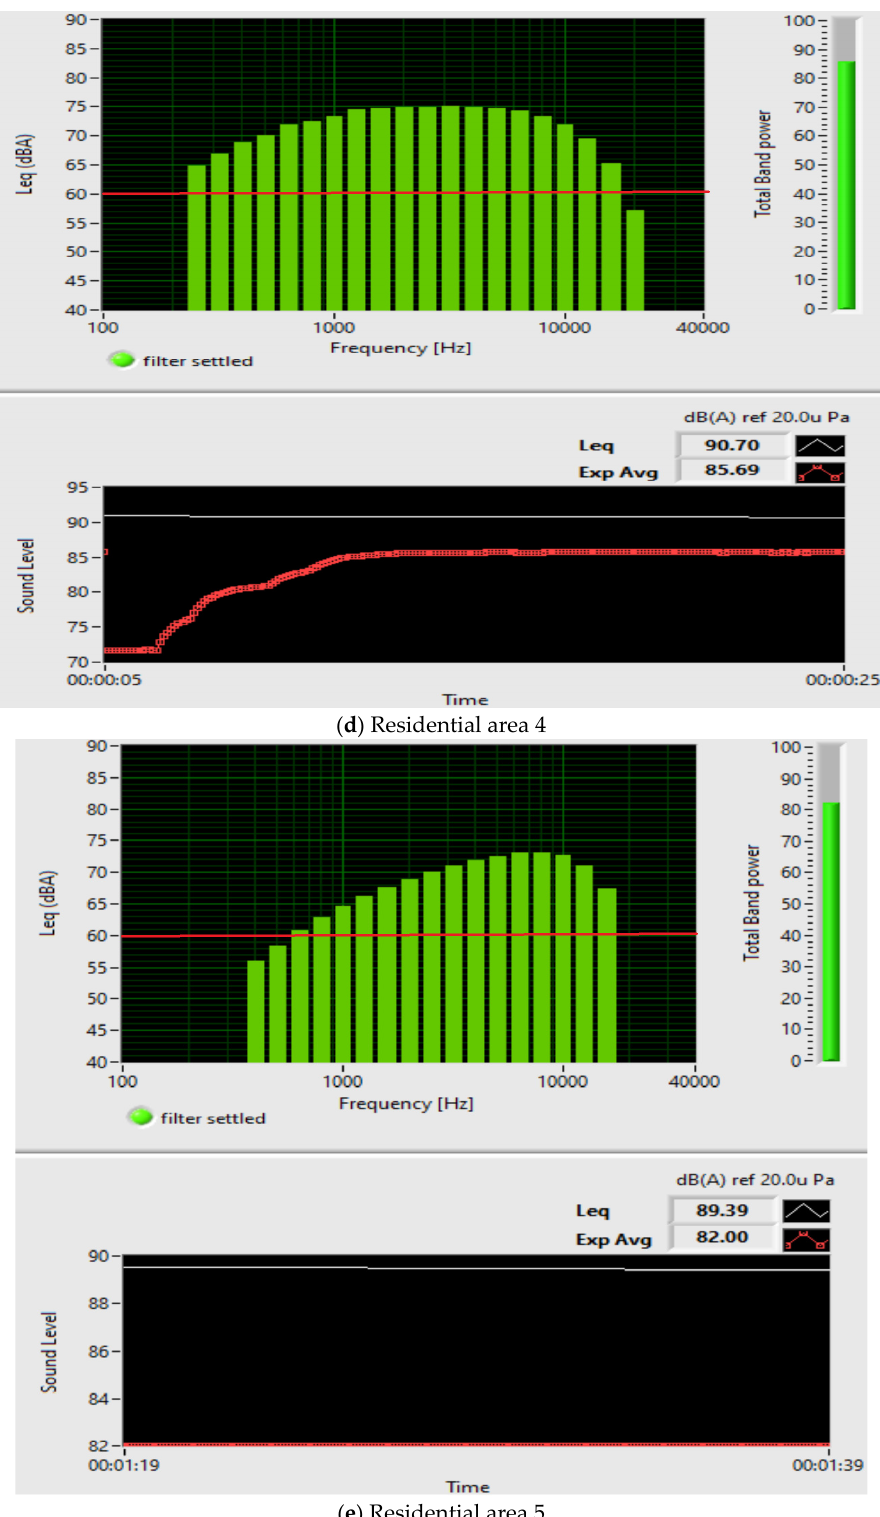
Figure 24. Noise pollution levels determined for five residential areas in Bucharest, Romania.